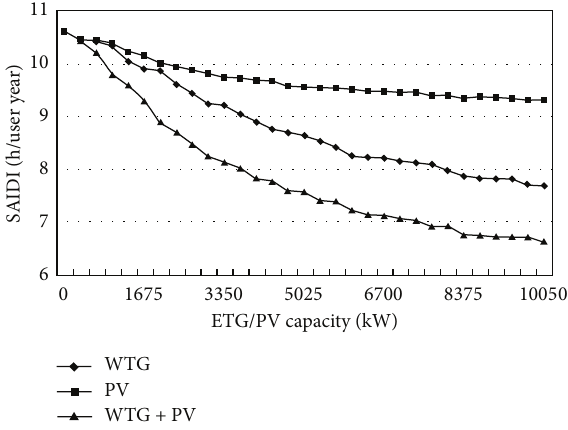
Figure 8: SAIDI variation as function of WTG/PV